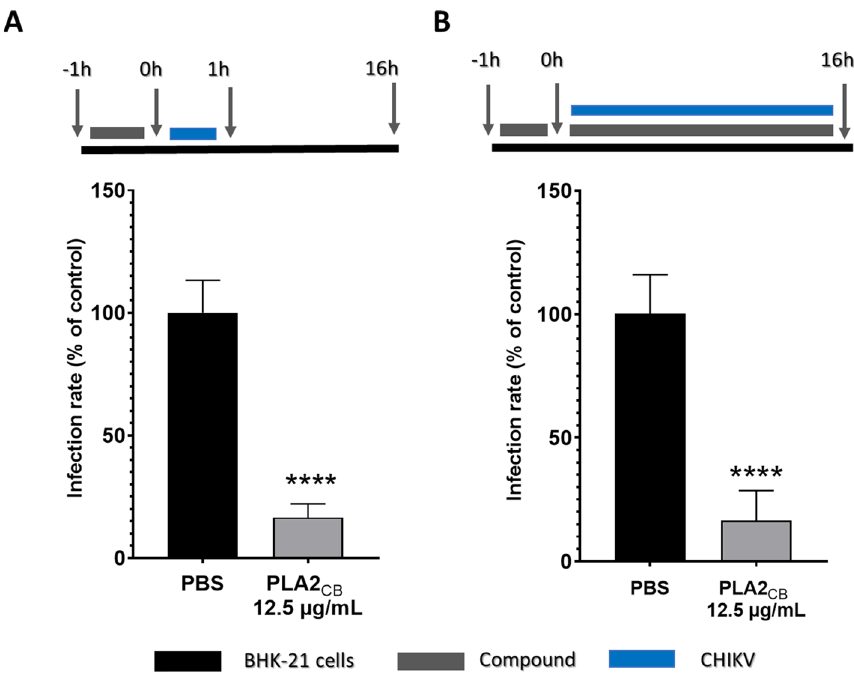
Figure 2. PLA2 CB protects cells against CHIKV infection. ( A ) BHK-21 cells were treated with PLA2 CB at 12.5 μg/mL for 1 h. Then, cells were washed and infected with CHIKV- nanoluc at MOI 0.1 for 1 h. The compound-containing medium was removed and replaced with a fresh medium. ( B ) BHK-21 cells were treated with the PLA2 CB at 12.5 μg/mL for 1 h, then were infected with CHIKV- nanoluc in the presence of PLA2 CB . For both assays, CHIKV replication was measured by nanoluc activity at 16 h.p.i.. Schematic representation of each time-based assay as indicated by BHK-21 cells (black bars), PLA2 CB (grey bars), and CHIKV- nanoluc (blue bars). Mean values ± SD of a minimum of three independent experiments each measured in triplicate. (****) P < 0.0001. All images were generated using GraphPad Prism 8 and GIMP 2.10.20 (www. gimp.